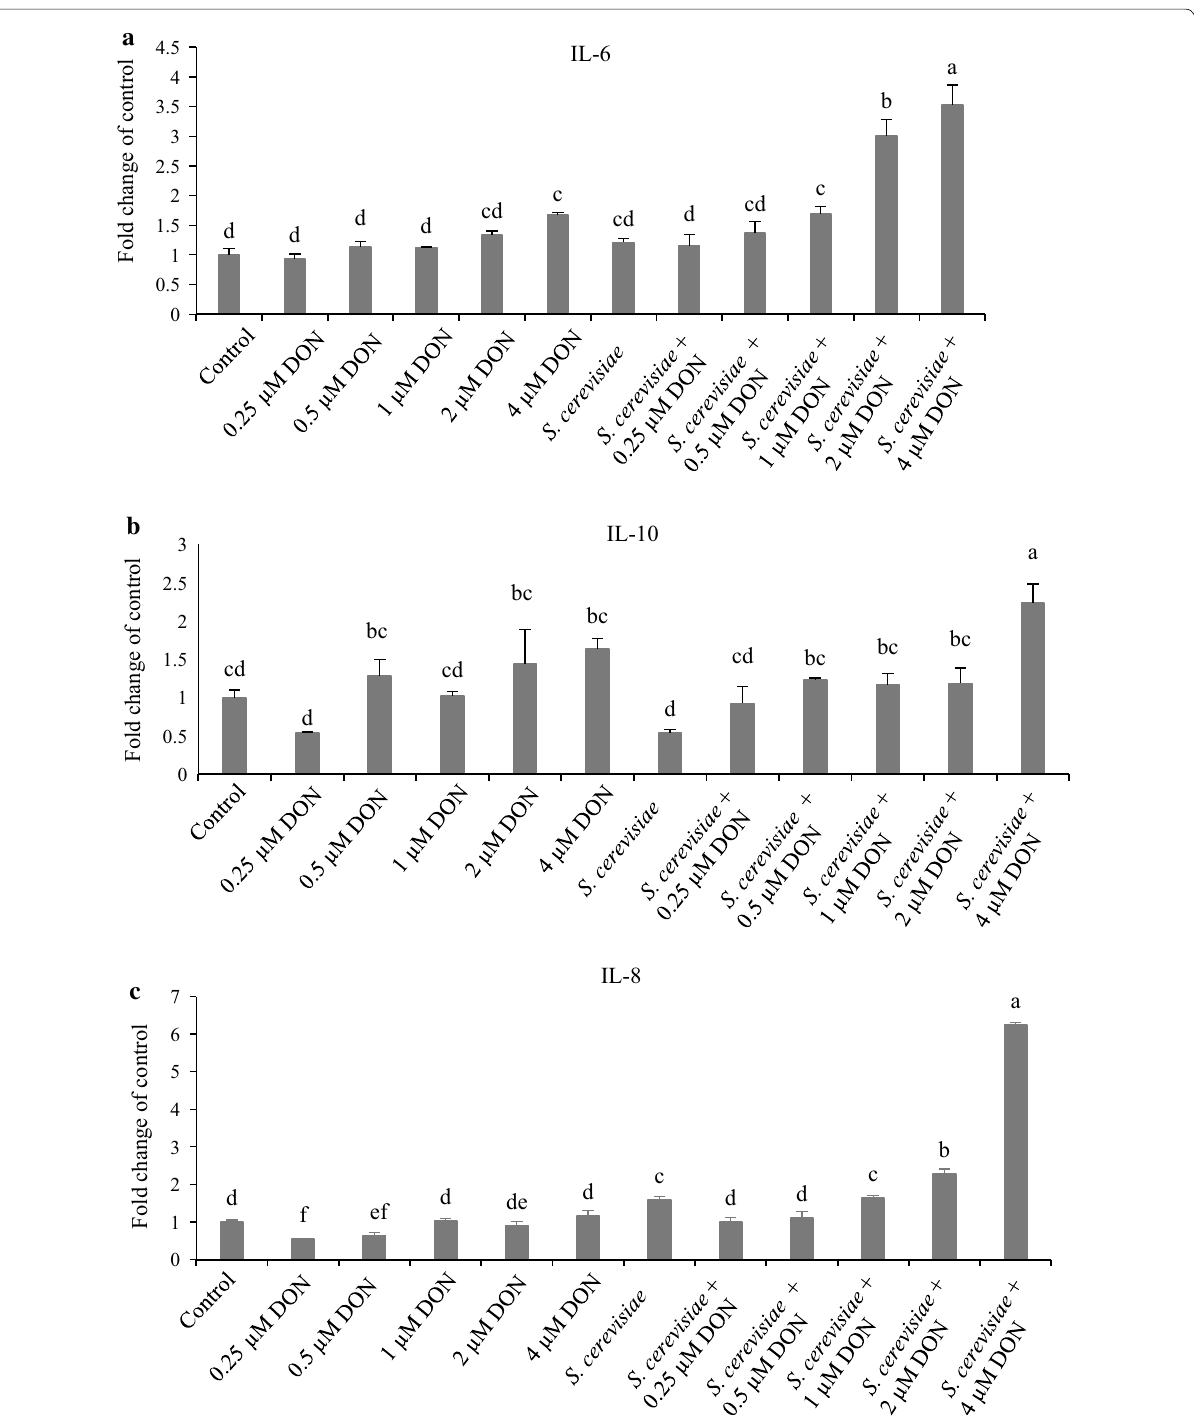
Fig. 3 Cytokine and TJP mRNA abundances of IPEC‑J2 cells affected by DON and S. cerevisiae after incubating for 8 h. The different lowercase letters among all the bars indicated the significant differences ( p < 0.05), while the same lowercase letters among all the bars indicated the insignificant differences ( p > 0.05). a IL‑6, b IL‑10, c IL‑8, d TJP‑1, e